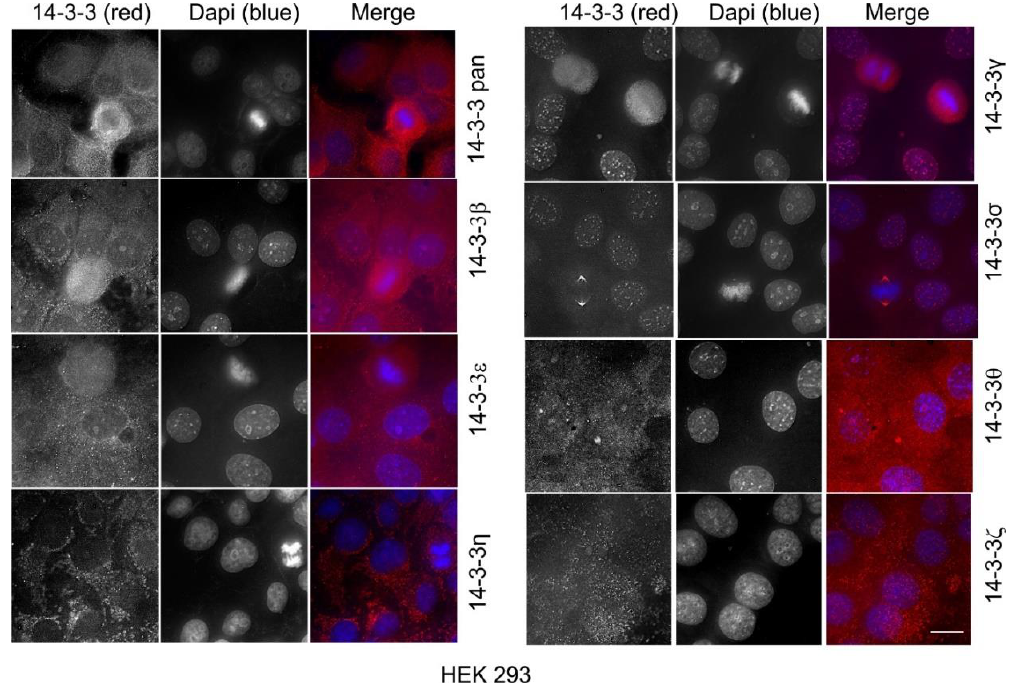
Figure 11. Subcellular localization of the total 14-3-3 protein and the seven 14-3-3 isoforms in HEK 293 cells by immunofluorescence. The total 14-3-3 protein was determined by a pan14-3-3 antibody. Each 14-3-3 isoform was determined by antibodies to each specific isoform. Immunoblotting, immunofluorescence, and subcellular fractionation were performed as described in Materials and Methods. 14-3-3 proteins were revealed by TRITC (red) and the chromatin was stained by DAPI (blue). Scale bar = 10 µm.